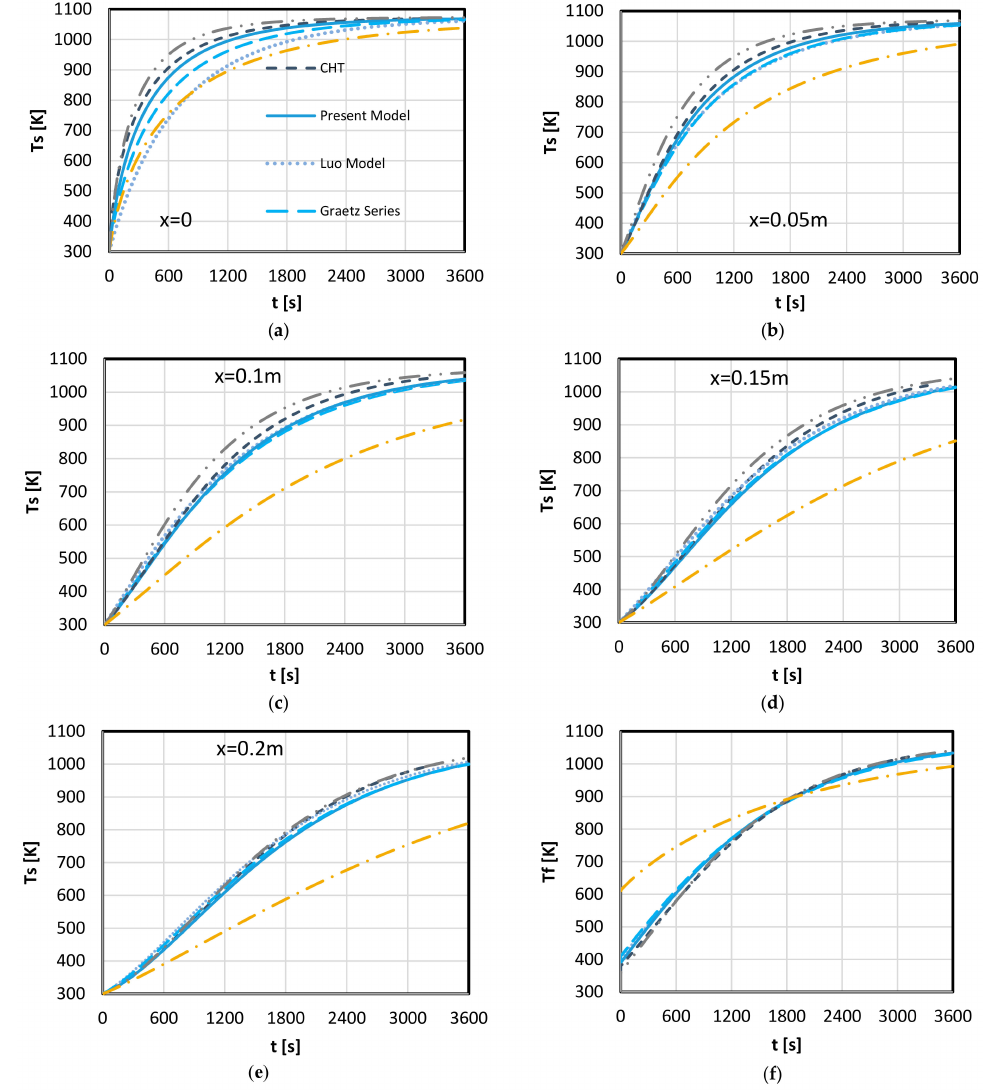
Figure 10. Results of one-dimensional model validation: Comparison between di ff erent Nusselt relationships and conjugate heat-transfer analysis. The temperature variation of the solid with time ( a ) at x = 0; ( b ) at x = 0.05 m; ( c ) at x = 0.1 m; ( d ) at x = 0.15 m, ( e ) at x = 0.2 m; ( f ) the temperature variation of air with